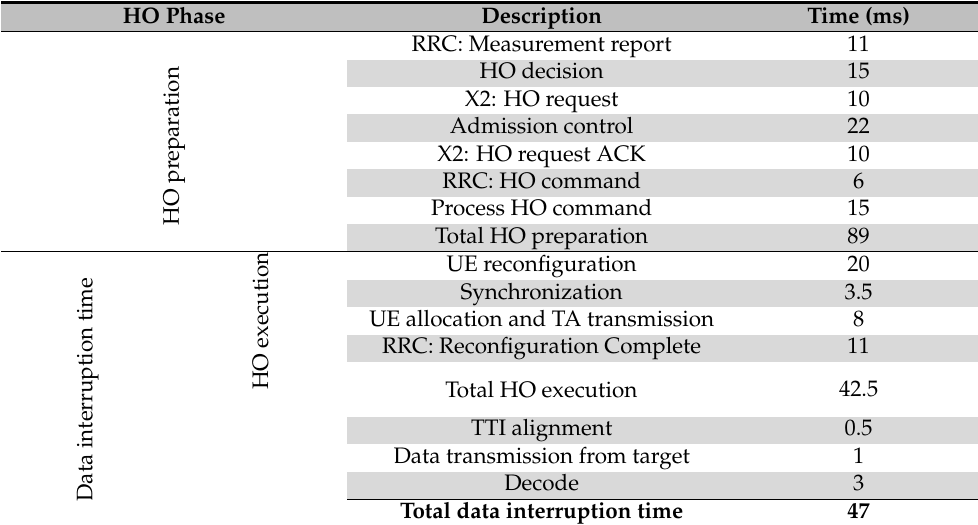
Table 4. Handover delay in LTE-A